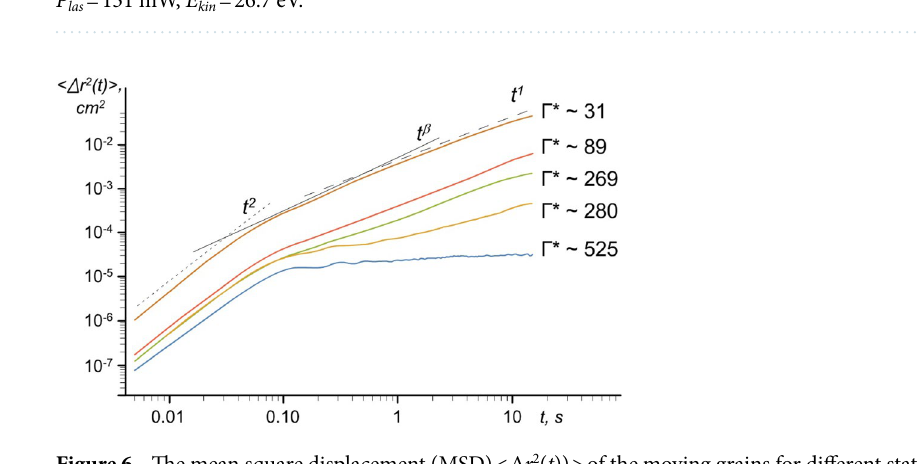
Figure 6. The mean square displacement (MSD) < Δ r 2 ( t )) > of the moving grains for different states of grain monolayer, solid and liquid, at different values of the coupling parameter, Γ * : 1—Γ * = 525; 2—Γ * = 280; 3—Γ * = 269; 4—Γ * = 89; 5—Γ * =